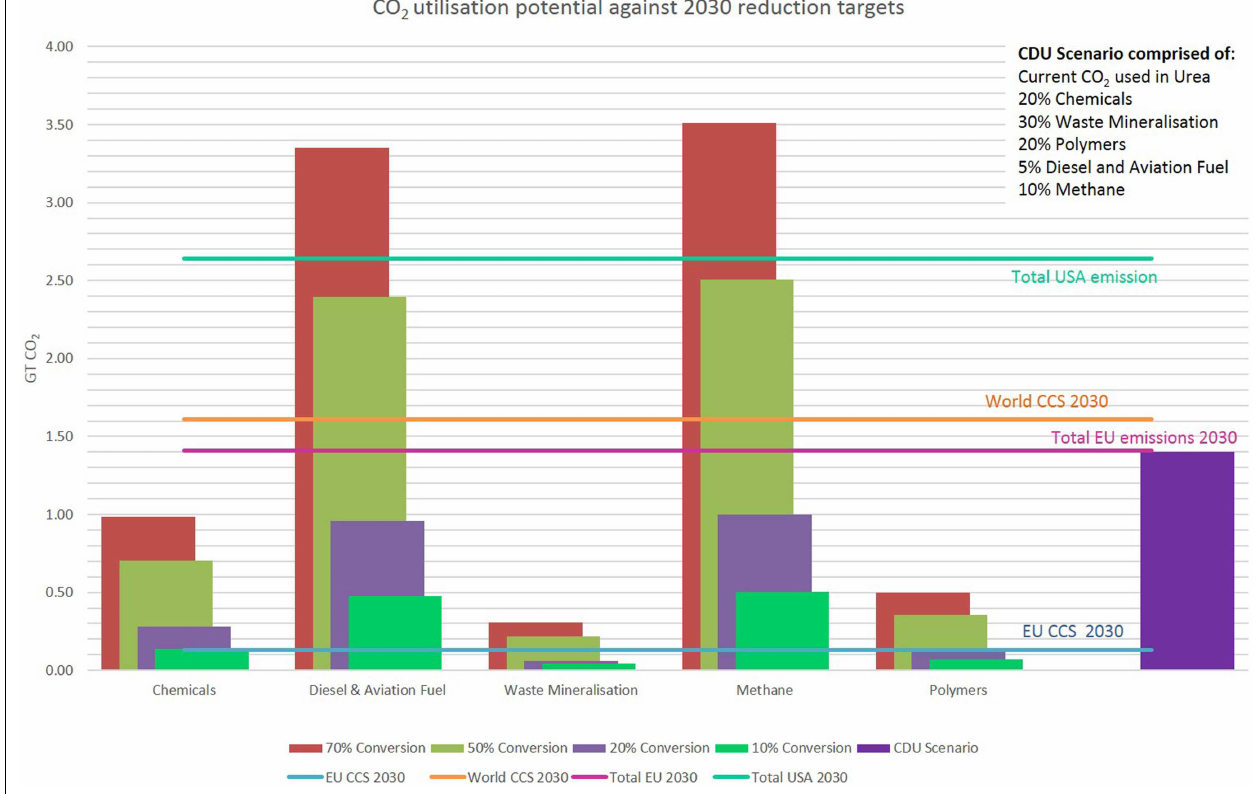
FIGURE 3 | Replacement of fossil-derived chemicals and fuels by CDU replacements assessed against CO 2 emission reduction targets in the EU, USA, and globally